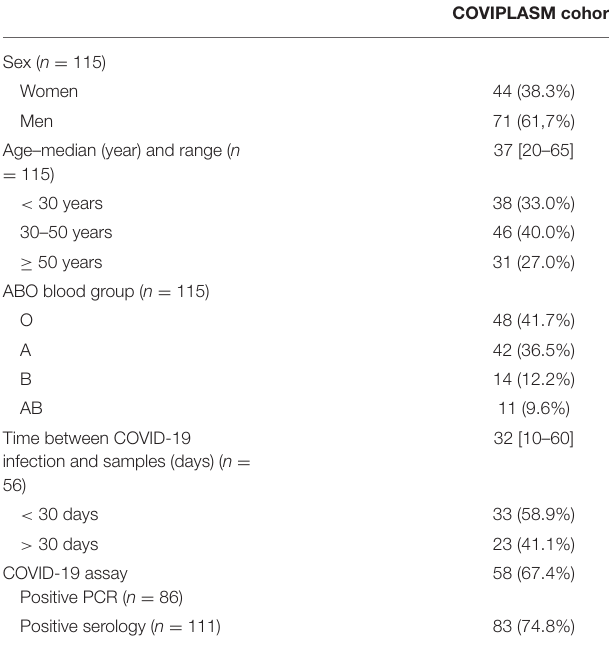
TABLE 1 | Characteristics of SARS-CoV-2 convalescent plasma